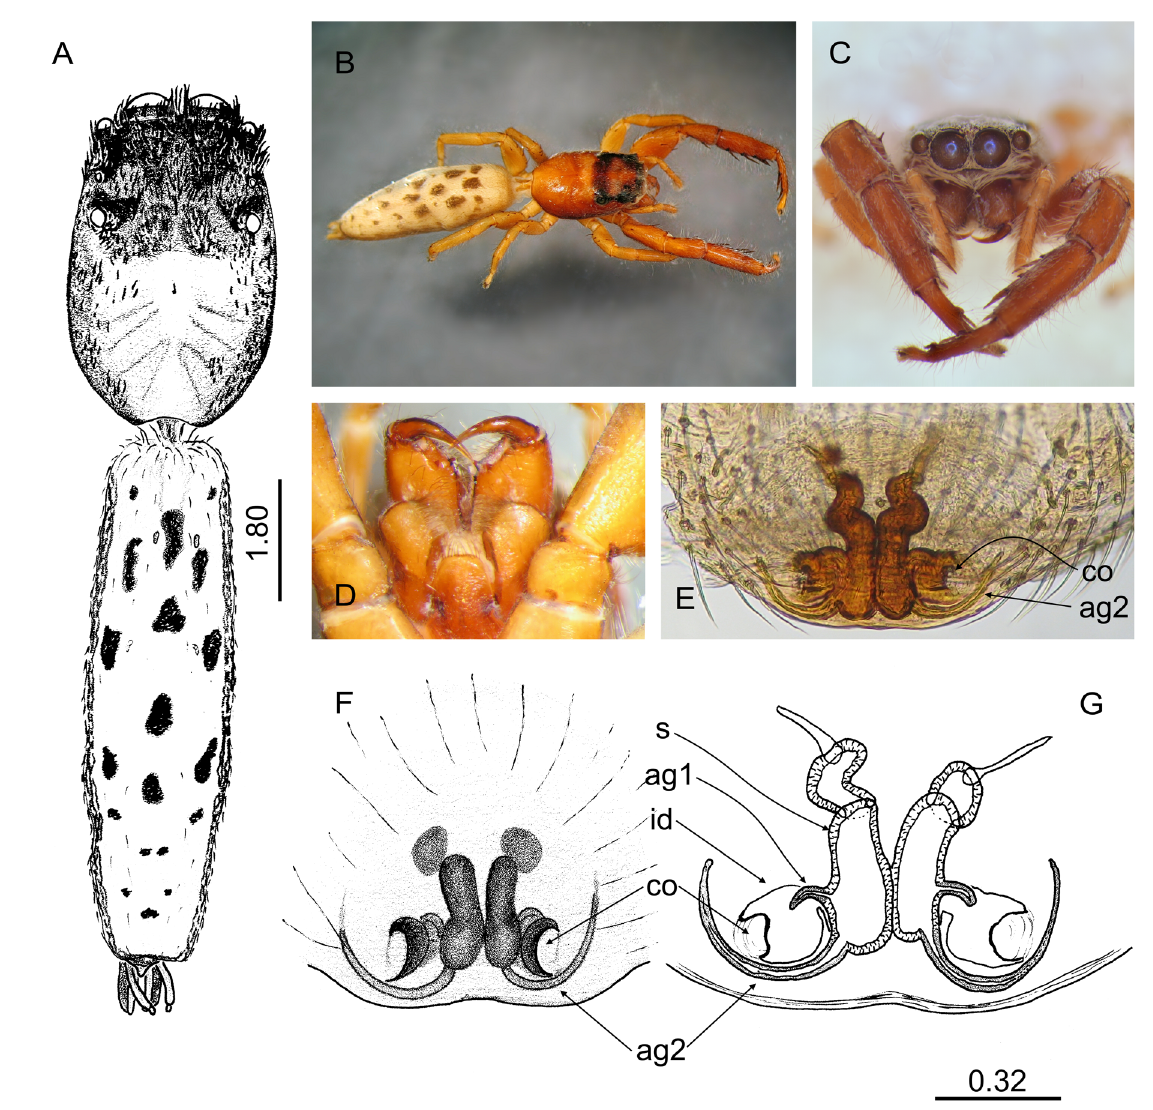
Fig. 8. Corambis pantherae sp. nov., holotype, ♀ (QMB S35653). A–C . Dorsal and frontal views. D . Chelicerae, maxillae and labium. E, G . Internal genitalia. F .